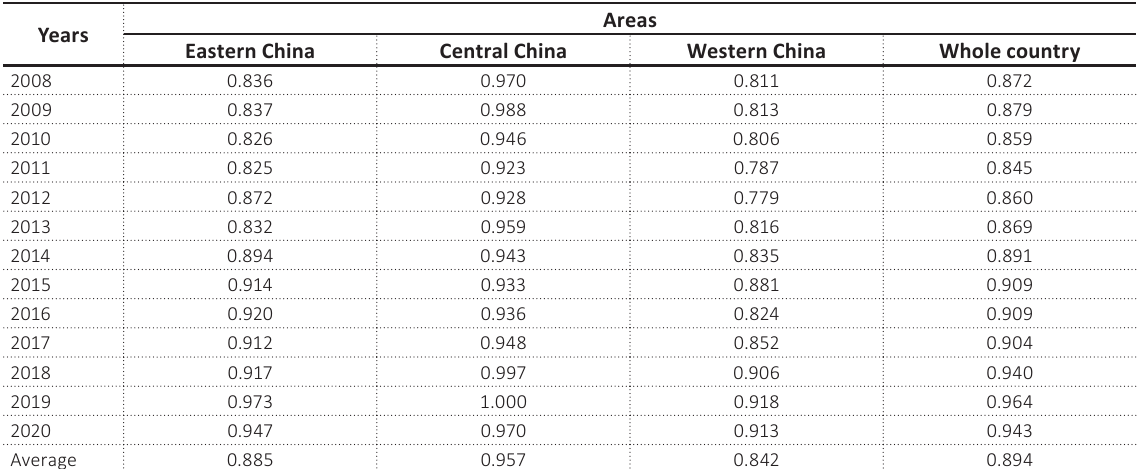
Table 3. Chinese GFHE performance from 2008 to 2020 (comprehensive efficiency)